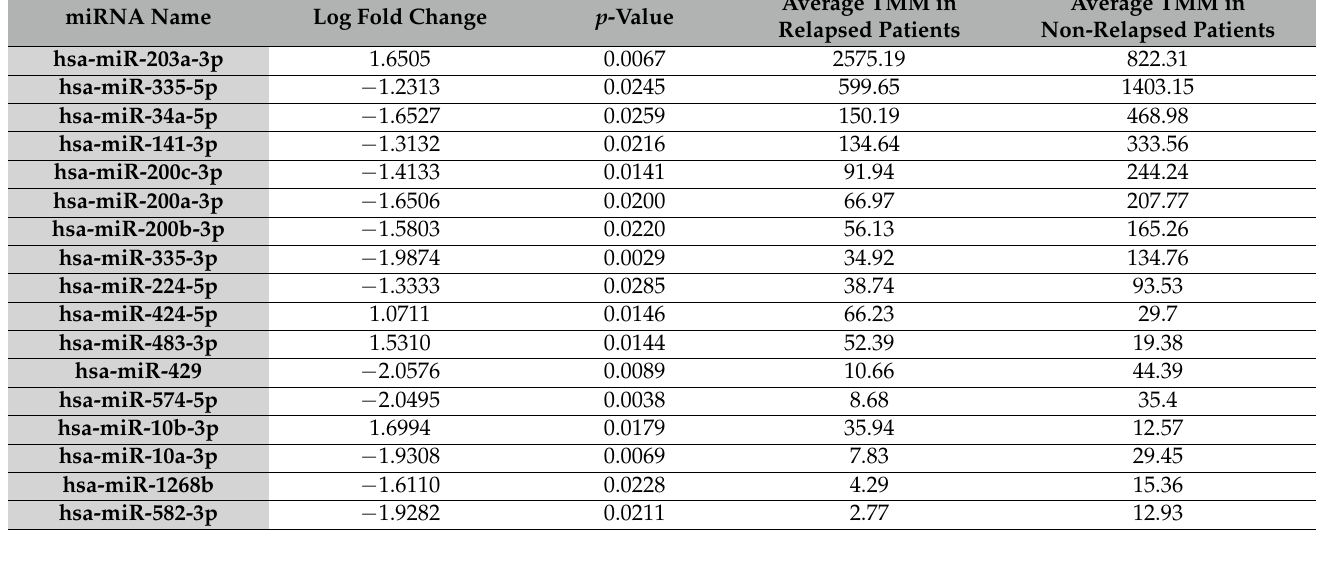
Table 2. miRNAs differentially expressed in EV pulmonary TDV from relapsed vs. non- relapsed patients ordered according to their level of expression in descending order. The average trimmed mean of M-values (TMM) normalization for each miRNA is indicated for relapsed and non-relapsed patients.